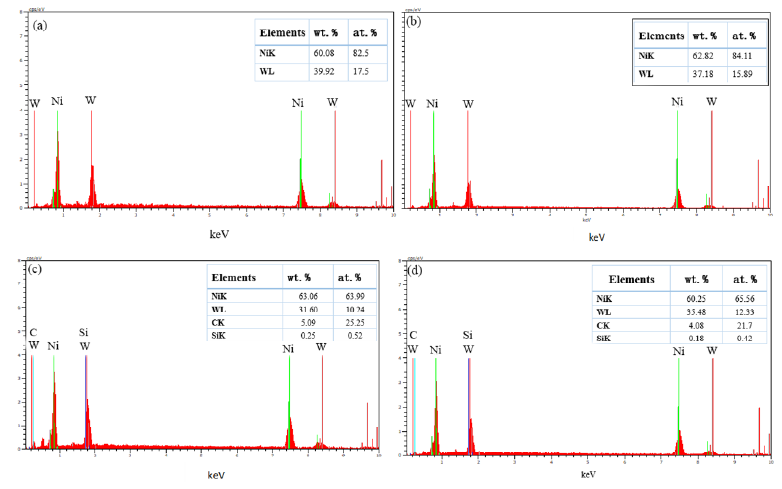
Figure 9. EDS spectra of ( a ) Ni-W(P), ( b ) Ni-W(GB), ( c ) Ni-W/SiC(P) and ( d )